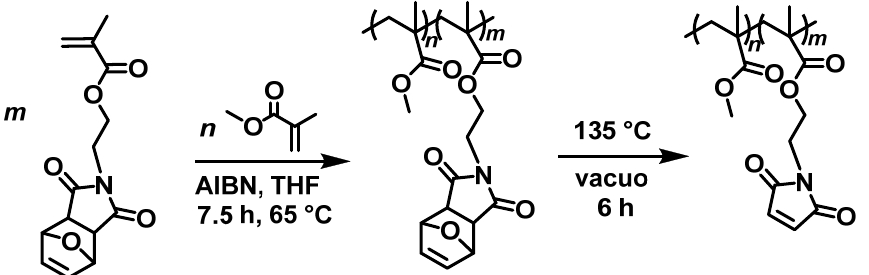
Figure 6. Reaction scheme of the copolymerization of methyl methacrylate and furan-protected maleimide methacrylate and deprotection of the maleimide side groups.